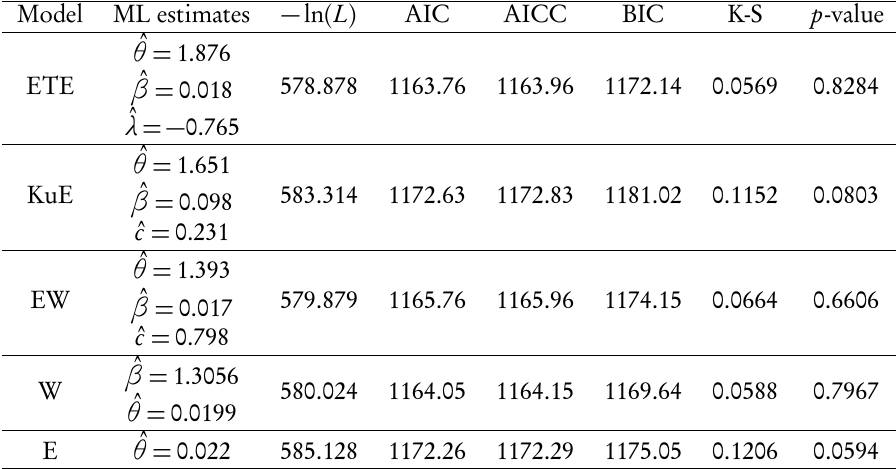
Parameter estimates and goodness of fit statistics for various models fitted for the second data